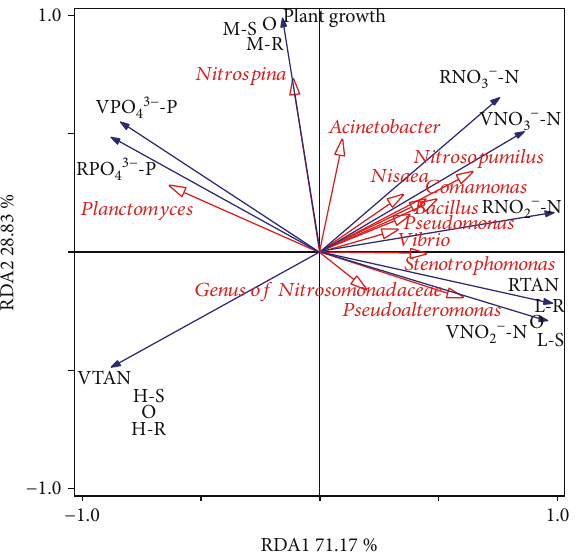
Figure 6: Redundancy analysis (RDA) biplot showing the relationship among functional genera in the sequencing data, nutrients ’ variation and removal rates, and plant growth. The fi rst axis is horizontal, and the second axis is vertical. RTAN, − -N, RNO − -N, and RPO 43 − -P represent the removal rates RNO 2 3 − -N, NO − -N, and PO 43 − -P, respectively. VTAN, of TAN, NO 2 3 − -N, VNO − -N, and VPO 43 − -P denote the variation in TAN, VNO 2 3 − -N, NO − -N, and PO 43 − -P after CW treatment, NO 2 3